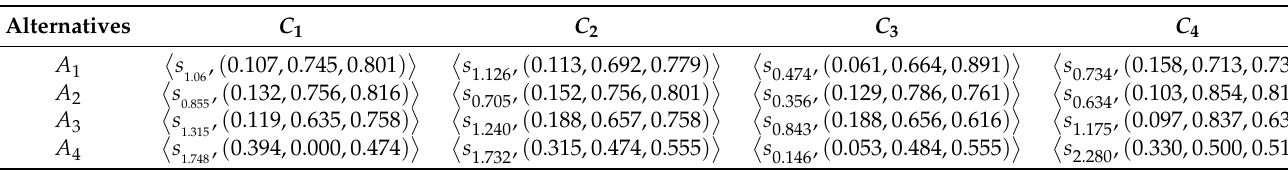
Table 8. Weighted collective SVNL decision matrix Y